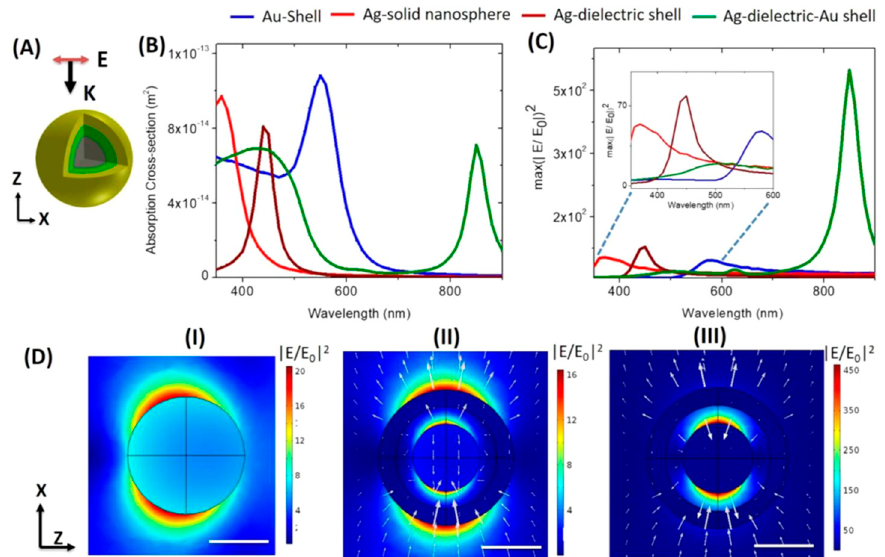
Figure 4. ( A ) HMCS structure consisting of an inner gray solid silver metal followed by a green silica dielectric layer and an outer gold shell. ( B ) The absorption cross – section of HMCS structure comparison. ( C ) The different cases of enhancements (maximum |E/E 0 | 2 in the entire volume). ( D ) Electric field distribution diagrams of solid metal nanoparticles ( I ), core – shell metal nanostructures ( II ), and HMCS ( III ) structures, respectively. Adapted with permission from [59], Copyright 2019, Springer Nature.